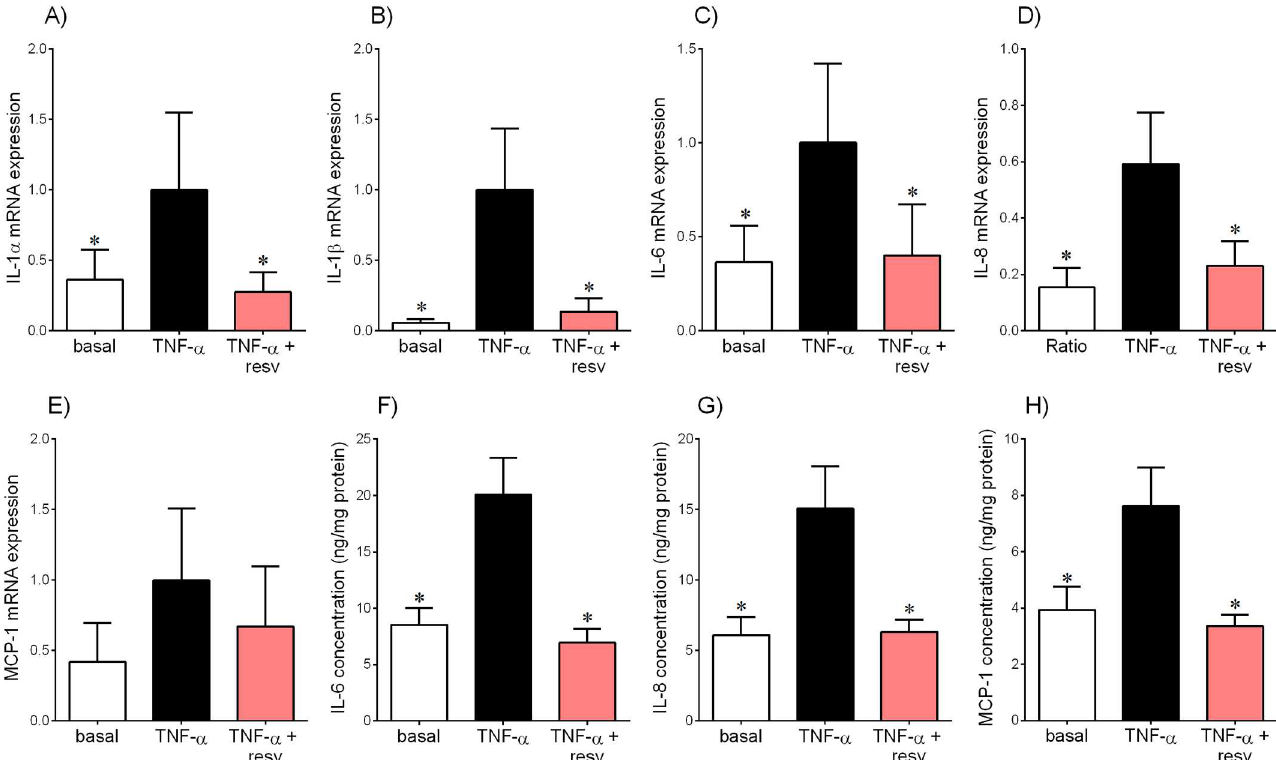
Fig 1. Effect of resveratrol on TNF- α -induced pro-inflammatory cytokines and chemokines in placenta. Human placenta was incubatedwith 10 ng/ml TNF- α in the absenceor presence of 200 μ M resveratrol (resv) for 20 h (n = 6 patients). (A-E) IL-1 α , IL-1 β , IL-6, IL-8 and MCP-1 mRNA expressionwas analysedby qRT-PCR and the fold change was calculatedrelative to TNF- α . (F-H) The incubation medium was assayed for concentration of IL-6, IL-8 and MCP-1 releaseby ELISA. All data are displayedas mean ± SEM. * P < 0.05vs. TNF- α